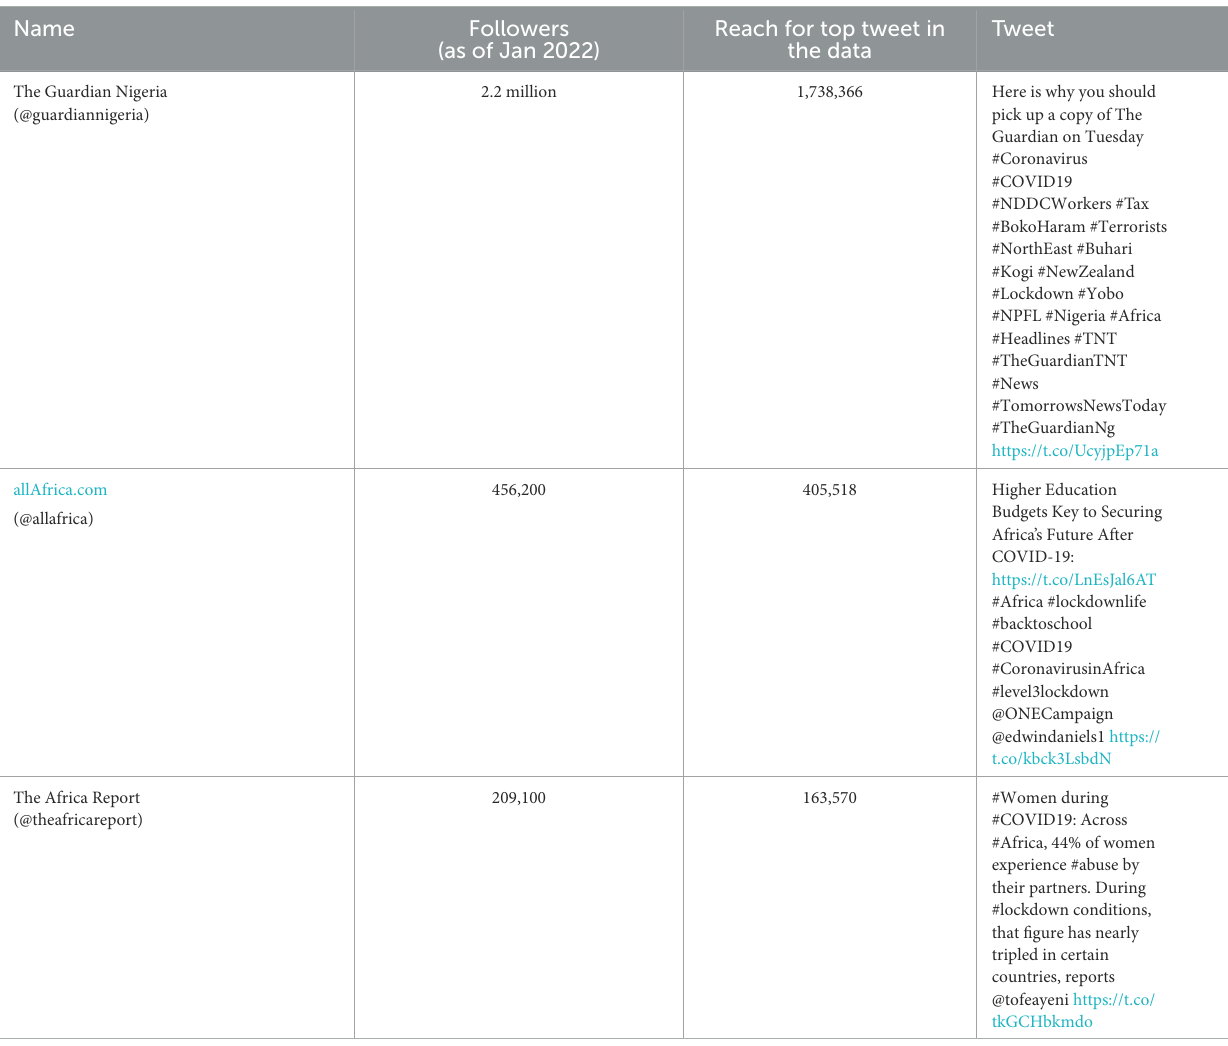
TABLE 3 The tweets with the highest